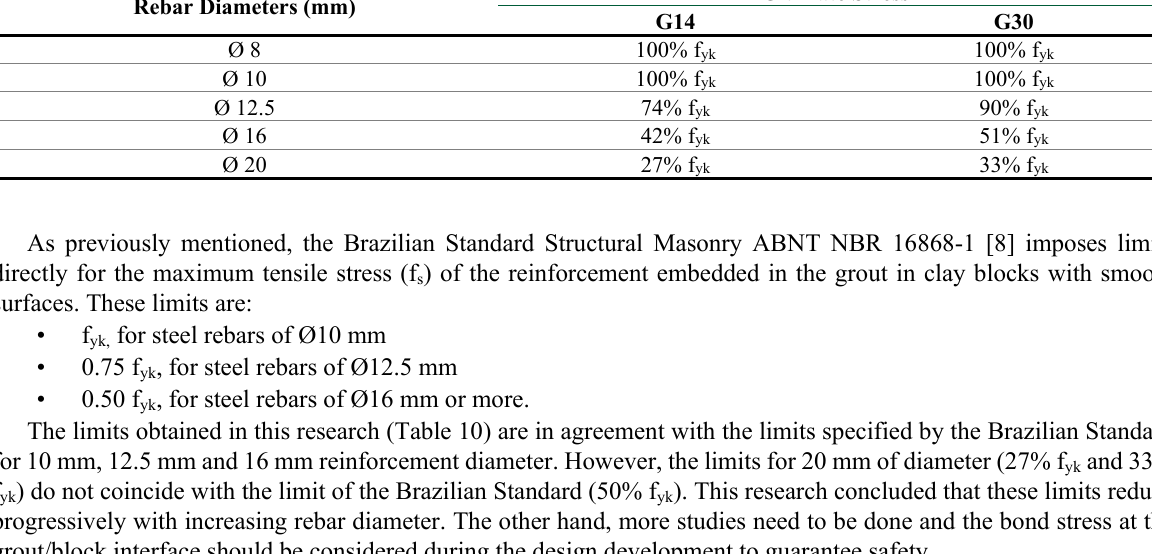
Table 10. Ultimate stress of the pull-out tests of clay blocks with respect to the yield stress of the steel rebar for different diameters. Rebar Diameters